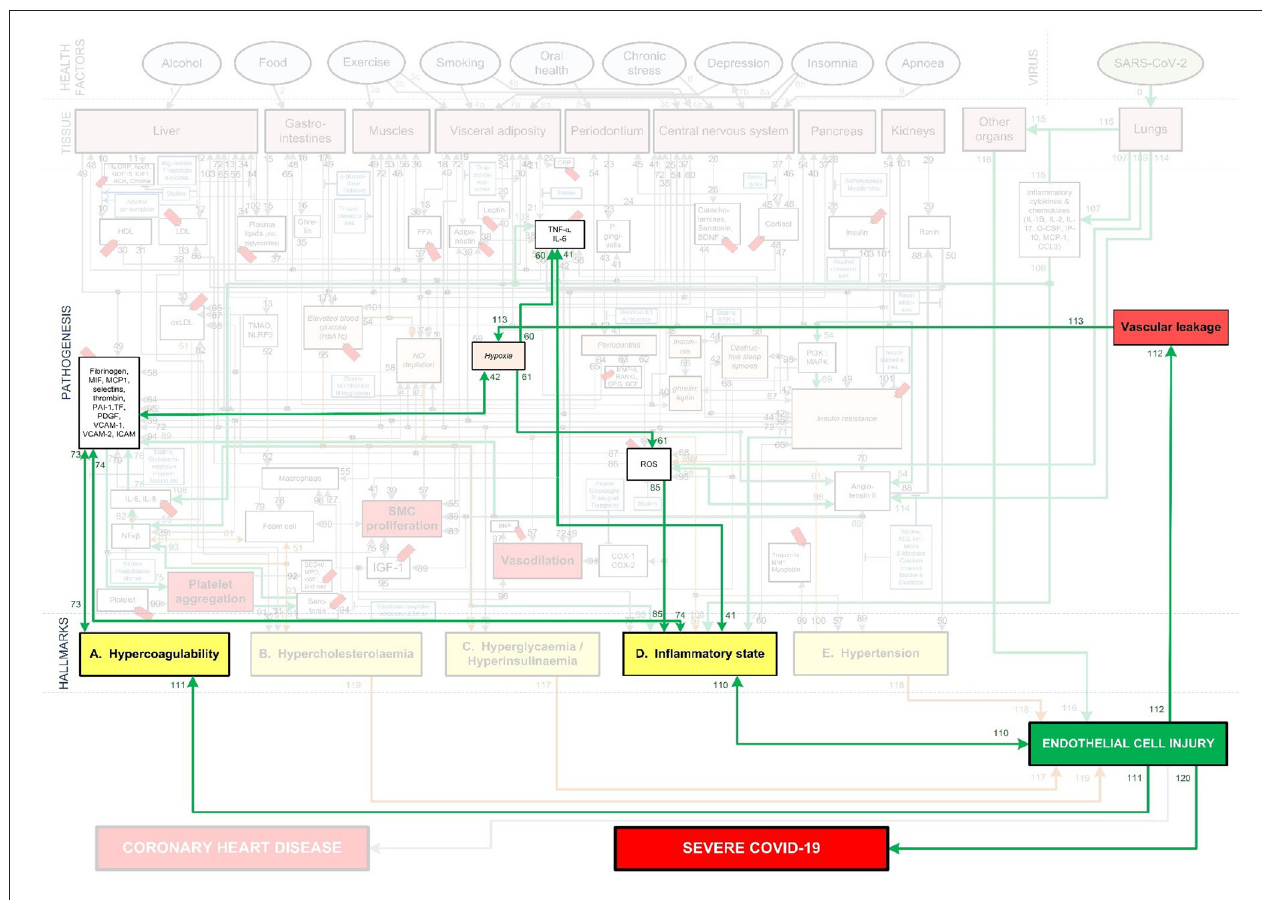
FIGURE 5 | Death spiral evident in some critical Covid-19